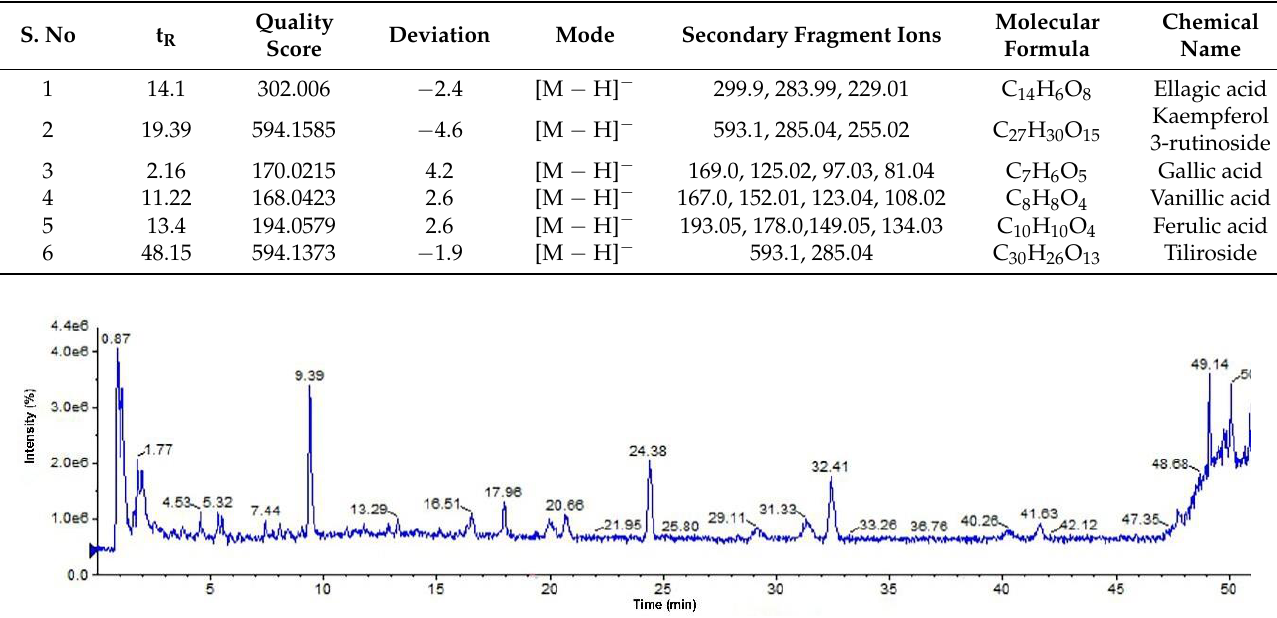
Table 1. UPLC-Q-TOF-MS ion fragments of six isolated phenolic compounds.